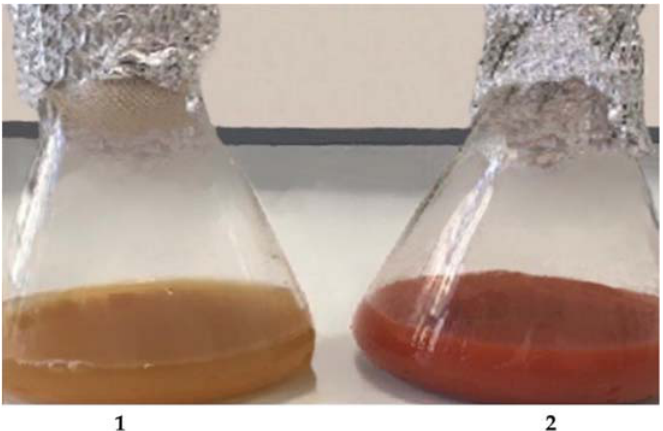
Figure 10. Selenite reduction by the 5AG strain grown in medium C, supplemented with molasses, at 36 °C for 24 h and 200 rpm. Flask 1: The 5AG strain grown in the absence of Na 2 SeO 3 . Flask 2: The 5AG strain grown in the presence of 200 ppm Na 2 SeO 3 .